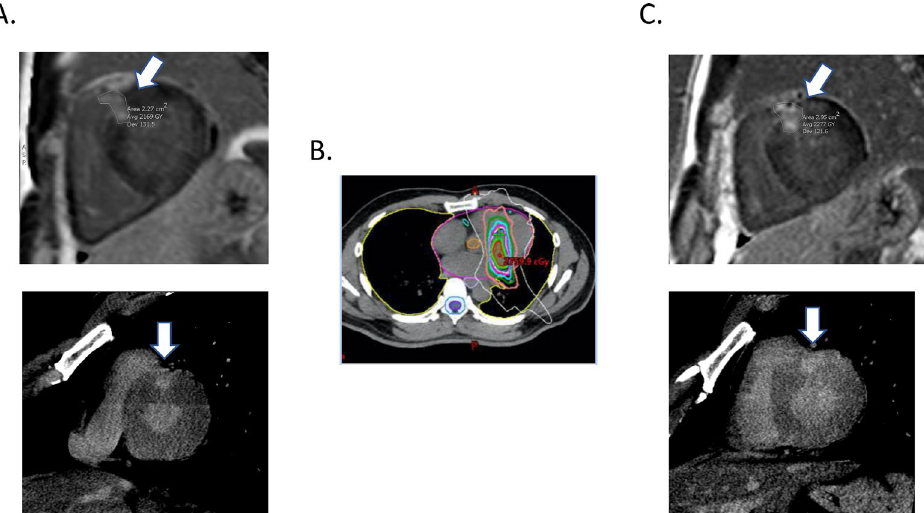
Figure 3. Pre- and post- treatment imaging comparison. ( A ) Pre-treatment CMR (upper part) and dual-energy CT (lower part) of patient 3 showed delayed enhancement of basal antero-septum (white arrow). ( B ) SBRT contour of patient 3. ( C ) Post-treatment CMR (upper part) and dual-energy CT (lower part) of patient 3 showed mildly increased delayed enhancement of basal antero-septum (white arrow). Pre-treatment scar area was 2.27 cm 2 , and post-treatment scar area was 2.95 cm 2 . The radioablation dose distribution figure was created by